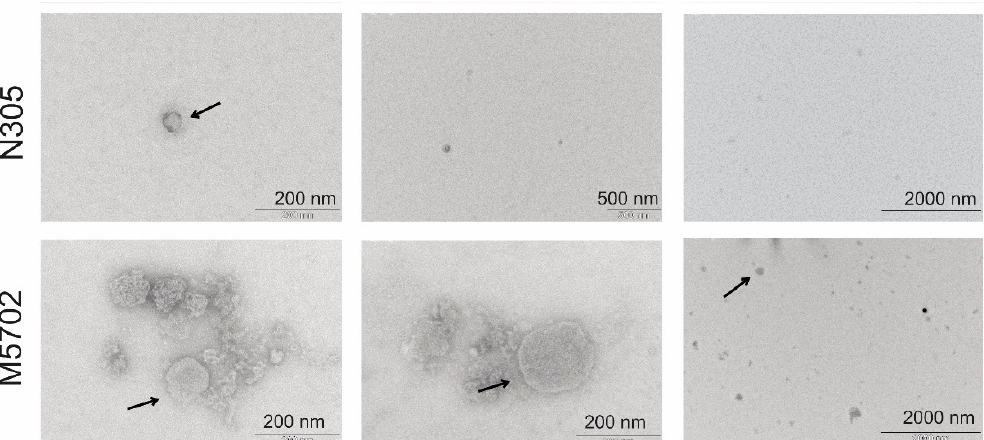
Figure 1. Transmission electron microscopy (TEM) observations of isolated S. aureus EVs for each mastitis strain Mastidis, M5512VL, USA300, N305 and M5702. Black arrows indicate EVs.